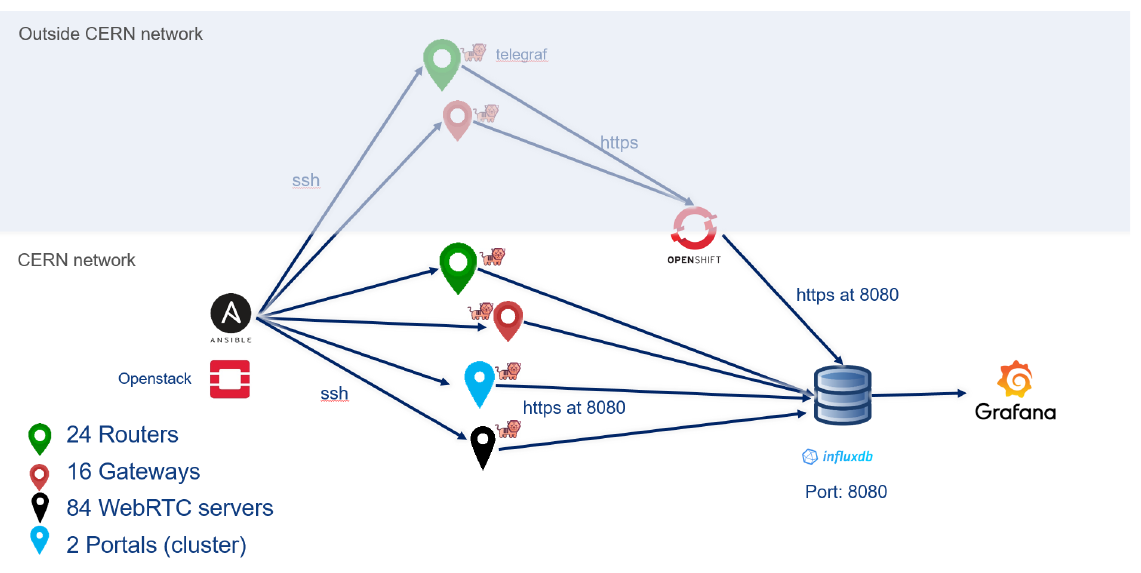
Figure 4. Deployment of software and configuration with